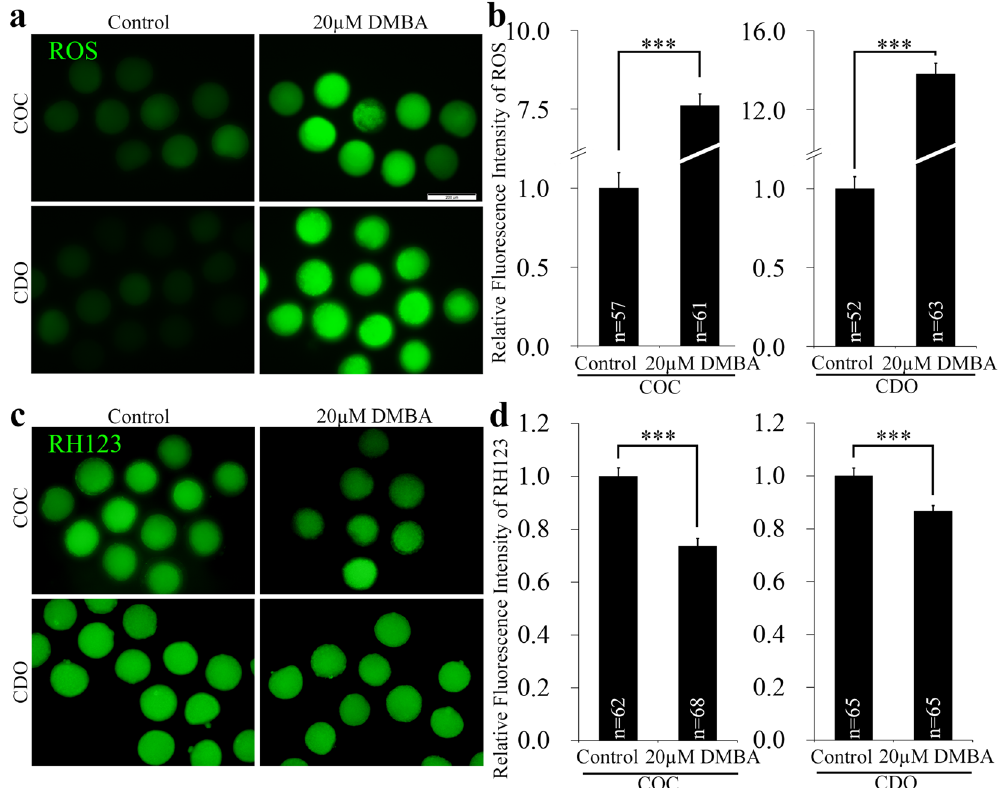
Figure 5. DMBA increased ROS level and decreased mitochondrial membrane potential in porcine mature oocytes. Representative fluorescence images were taken from mature oocytes stained with DCFH-DA ( a ) and RH123 ( c ). Scale bar, 200 μ m. The graphs were presented as relative fluorescence intensity of ROS ( b ) and RH123 ( d ) in mature oocytes. *** P <